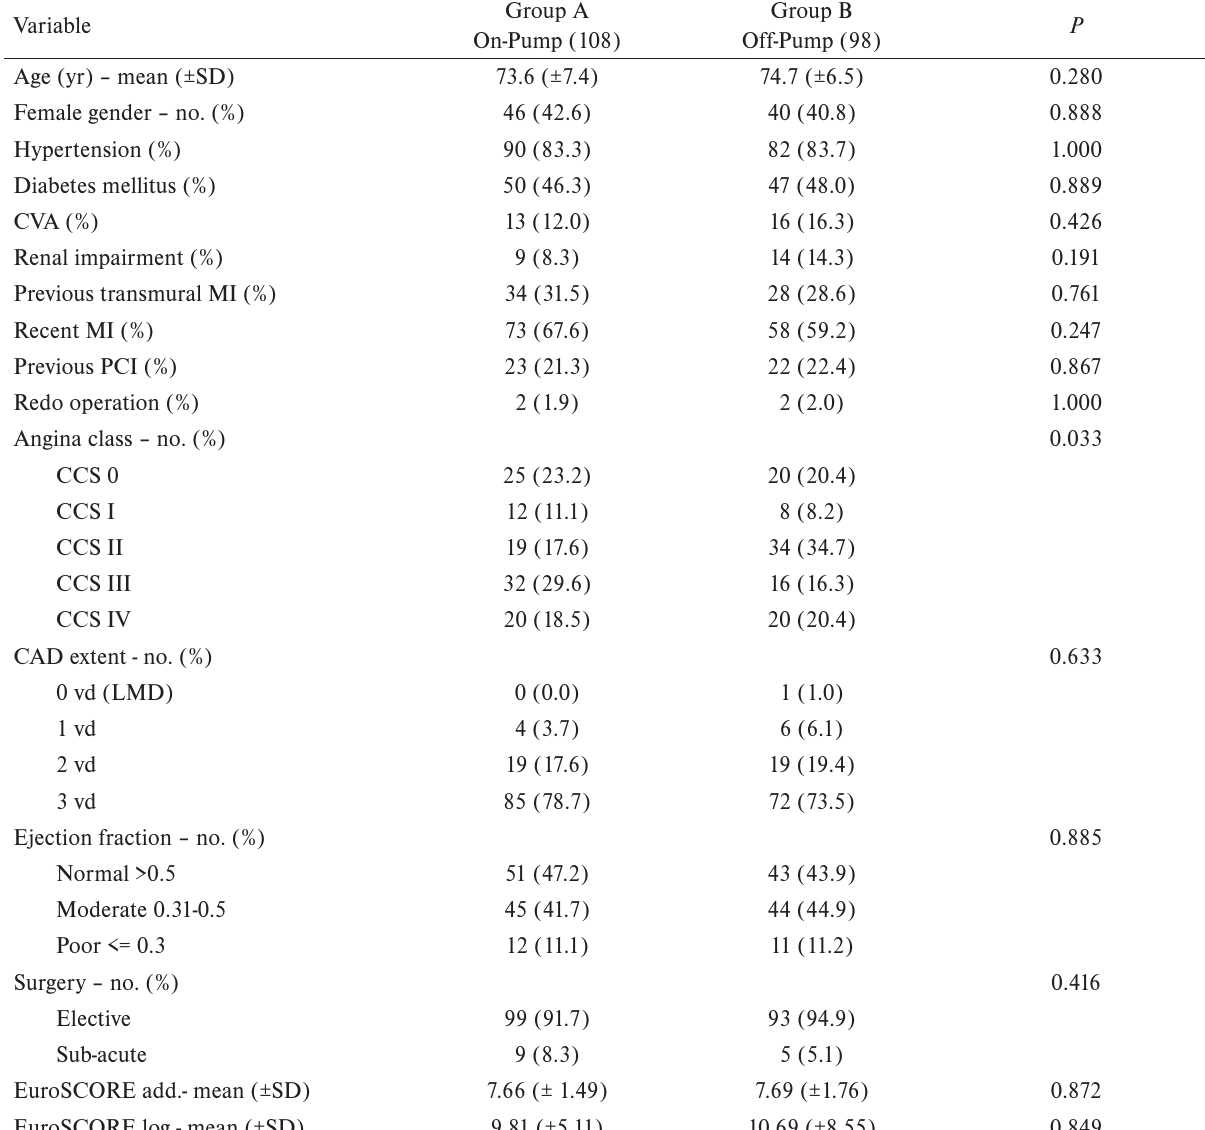
Table 1. Preoperative demographic